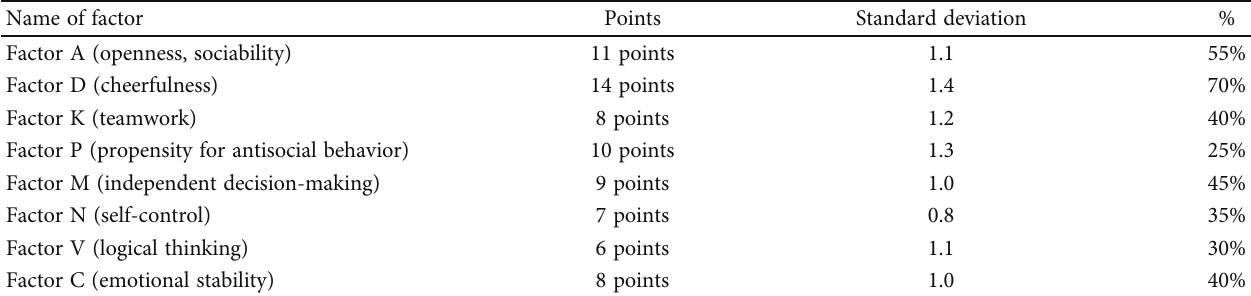
Table 2: Intermediate results.